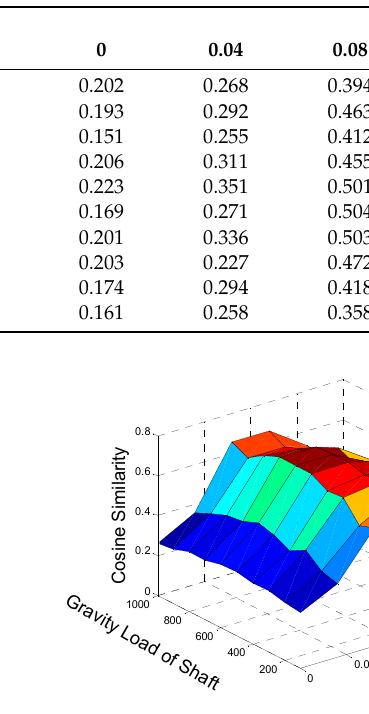
Figure 3. The cosine similarity between measured and simulated signals in normal state.